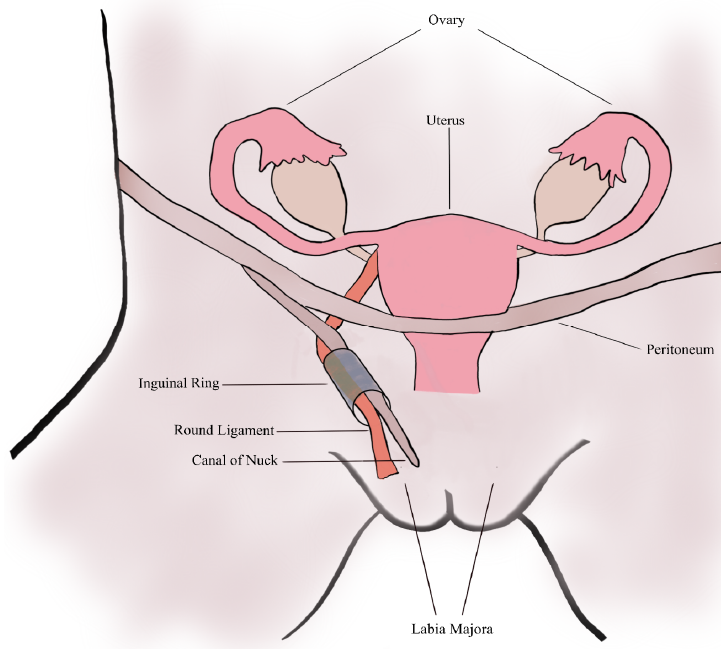
Figure 4. A schematic of the female anatomy and the patent canal of Nuck.